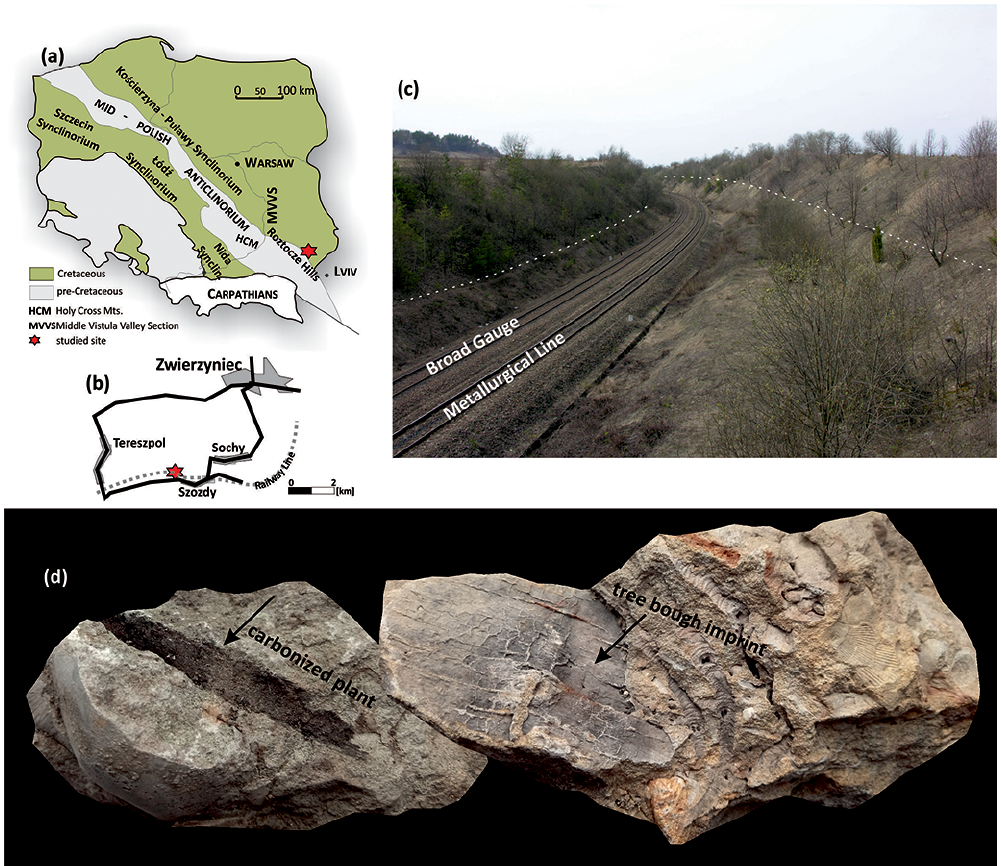
Figure 3. (a) Simplified geological sketch map of extra-Carpathian Poland, excluding the Cenozoic cover (adopted from Po˙zaryski, 1974); tectonic units after ˙Zela´zniewicz et al. (2011). (b) Detailed location of the studied section. (c) General view of the section – the exposures (white dashed lines) extend along both sides of the railroad cut over a distance of approximately 800m. (d) Carbonized plant fragment (left) – the specimen is ca. 10cm across; the imprint of tree bough (right) – the specimen is ca. 25cm